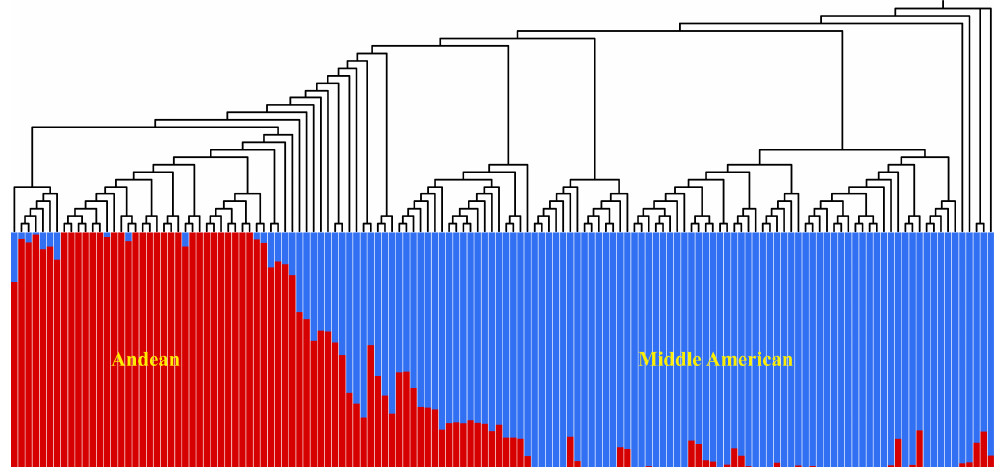
Figure 3. Neighbor-joining tree and population structure analysis using 97,841 single-nucleotide polymorphisms (SNPs). The genepools are colored with red for Andean and blue for Middle American ancestry.